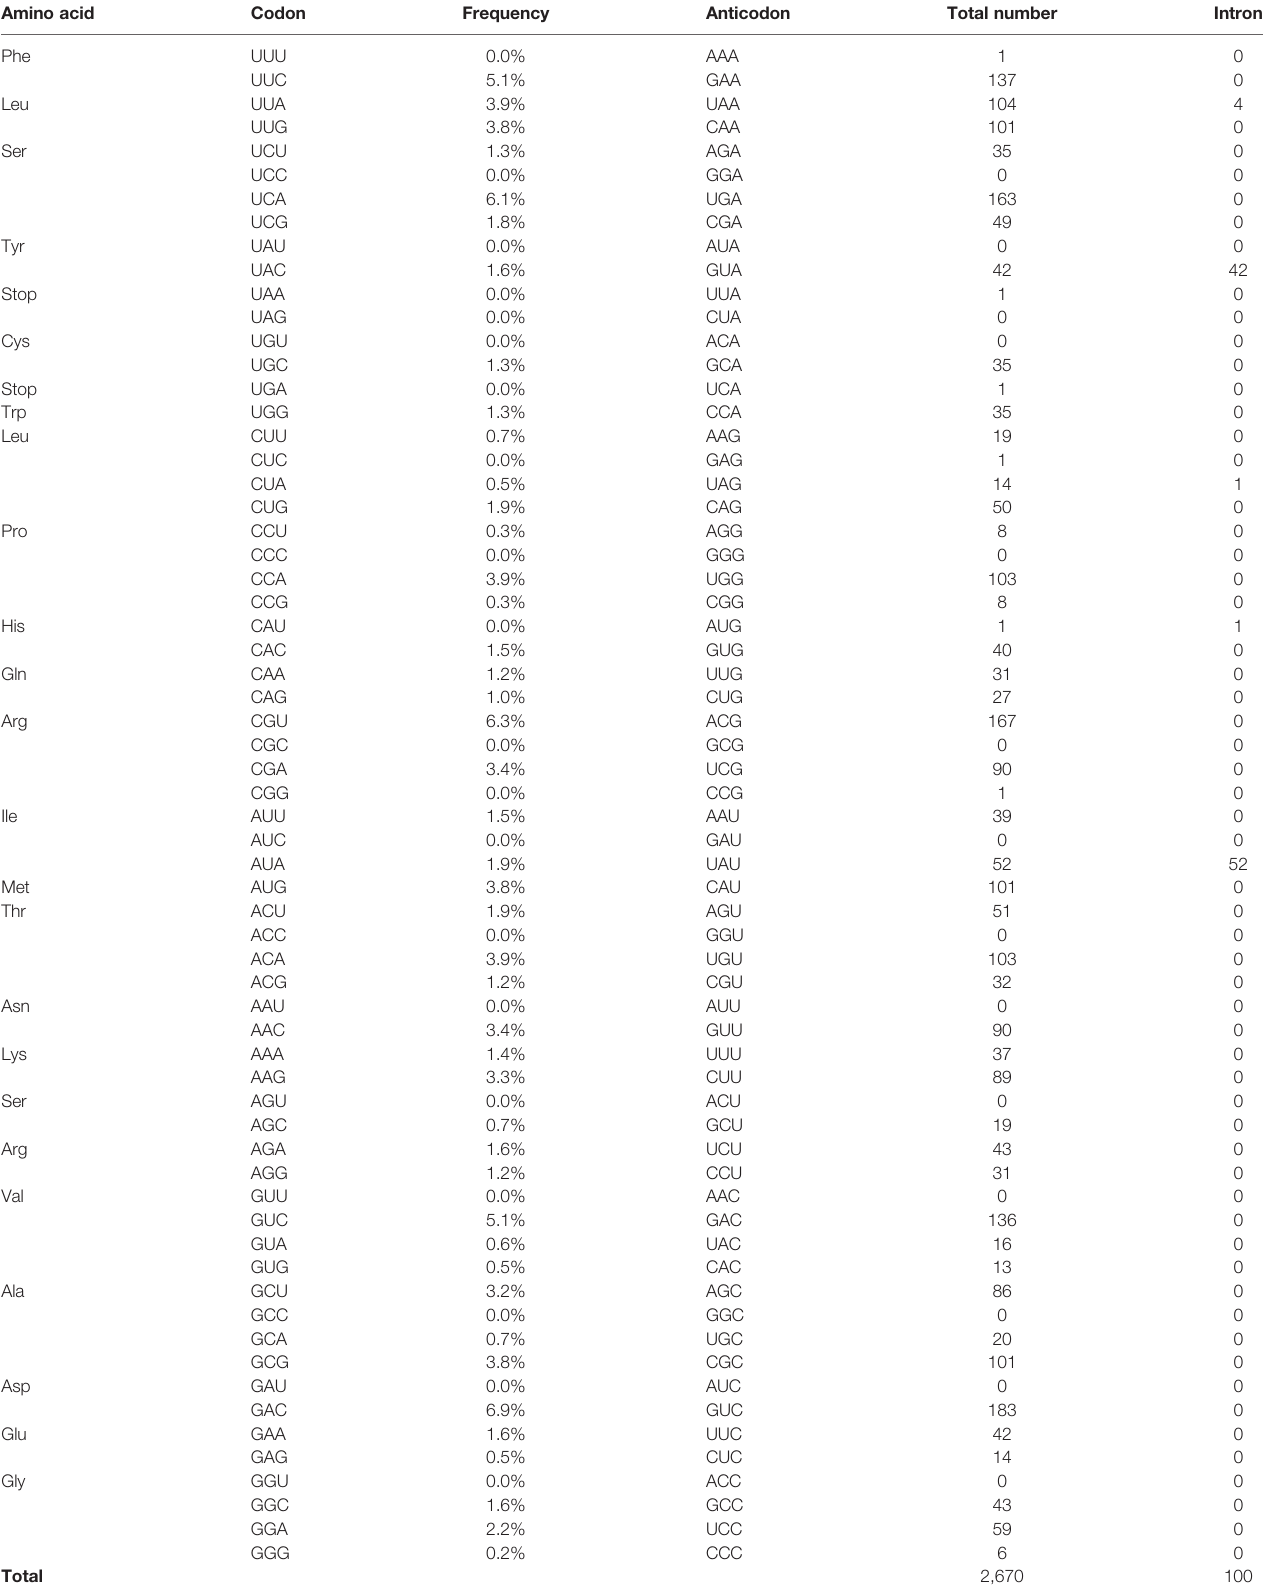
TABLE 1 | Codon frequency and intron-containing tRNAs in E. histolytica . Amino acid